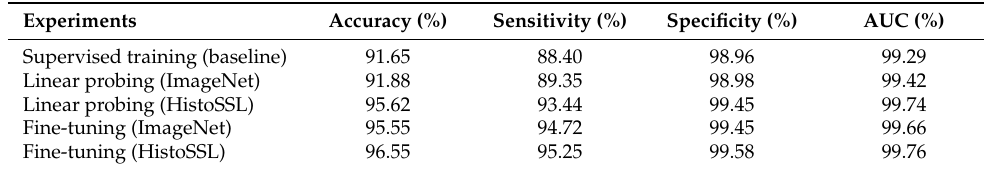
Table 8. Results of the ResNet-50 model under different settings: a. supervised training from scratch, b. linear probing on an ImageNet-pre-trained backbone, c. linear probing on HistoSSL pre- trained backbone, d. fine-tuning on an ImageNet-pre-trained backbone, e. fine-tuning on HistoSSL pre-trained backbone.